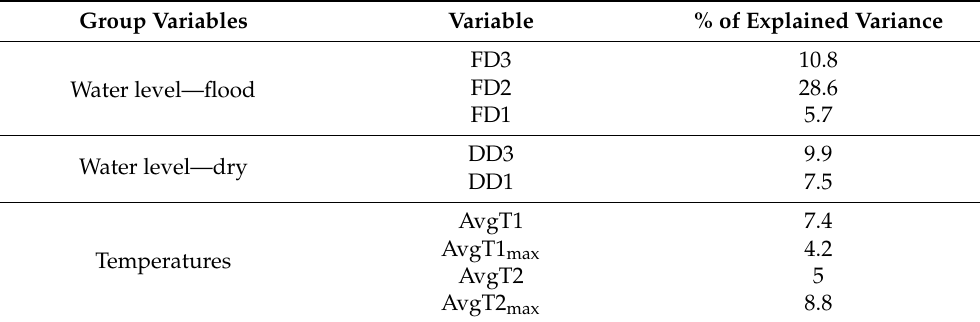
Table 4. The numerical results (conditional effects) of RDA. Ratio of variance in model parameters and above-ground biomass at the end of the season explained by water level data and temperature data at both reed stands. (FD3—number of flooded days during NDVI saturation; FD2—number of flooded days during the vegetative phase; FD1—number of flooded days before reed establish- ment; DD3—number of dry days during NDVI saturation; DD1—number of dry days before